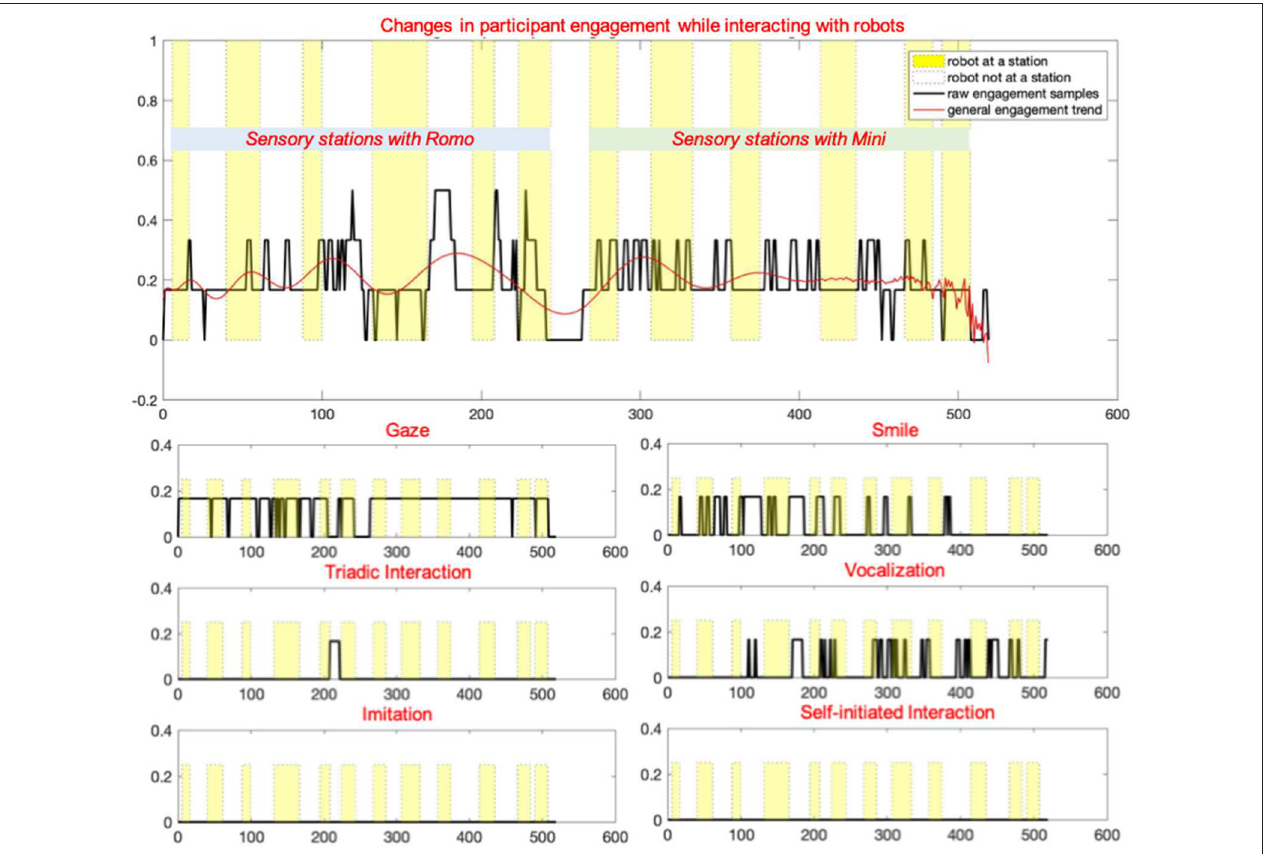
FIGURE 4 | Plots depicting changes in the overall engagement level of a child during an interaction, along with subplots of the target behaviors contributing to this engagement, adapted from Javed et al.